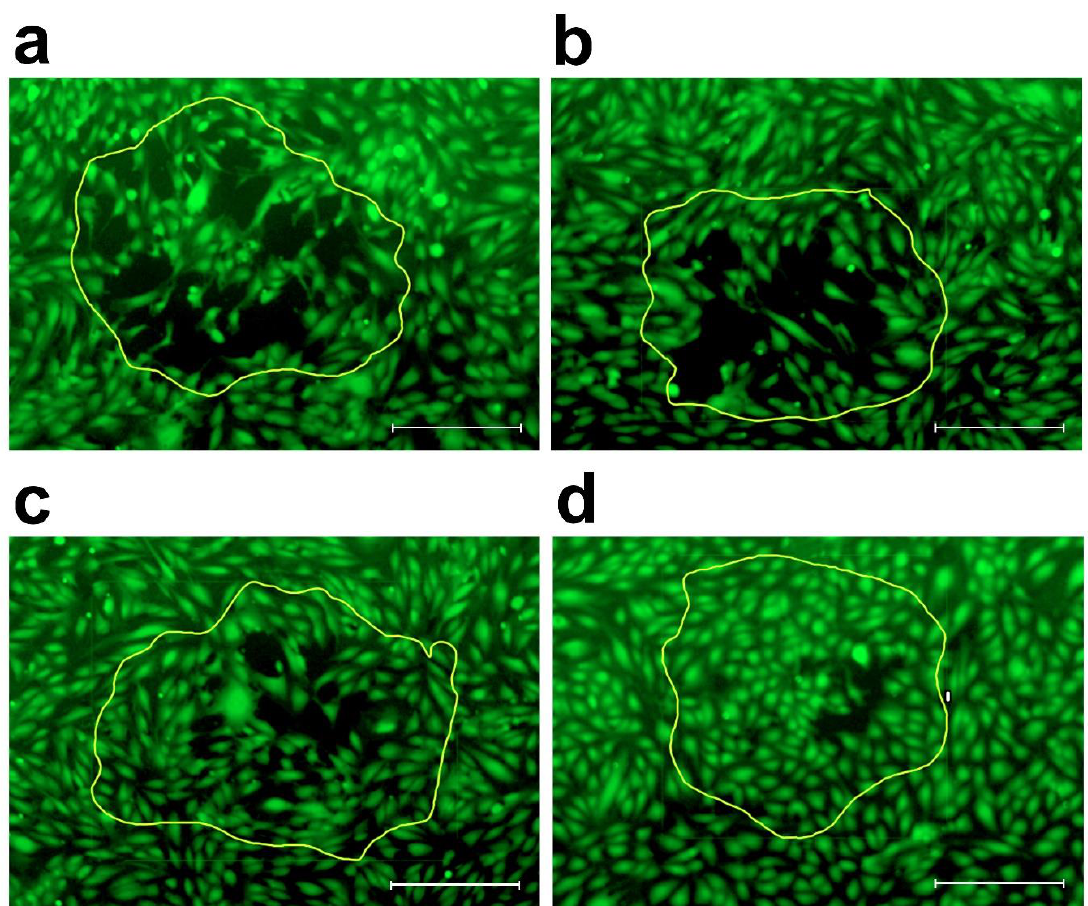
Figure 5. Inhibition of the formation of CCIDs by increasing concentrations of apigenin. SW620 cell spheroids and lymph endothelial cell monolayers (LECs) were pre-incubated either with ( a ) solvent (CO; DMSO), ( b ) 10 µM apigenin, ( c ) 25 µM apigenin and ( d ) 75 µM apigenin for 20 min. Then, apigenin pre-treated SW620 spheroids were placed on top of apigenin pre-treated LECs and co-cultivated for 4 h. Subsequently, the development of CCIDs within the LEC-layer was photographed. The bright lines contour the positions of the spheroids. Scale bars: 200 µM.